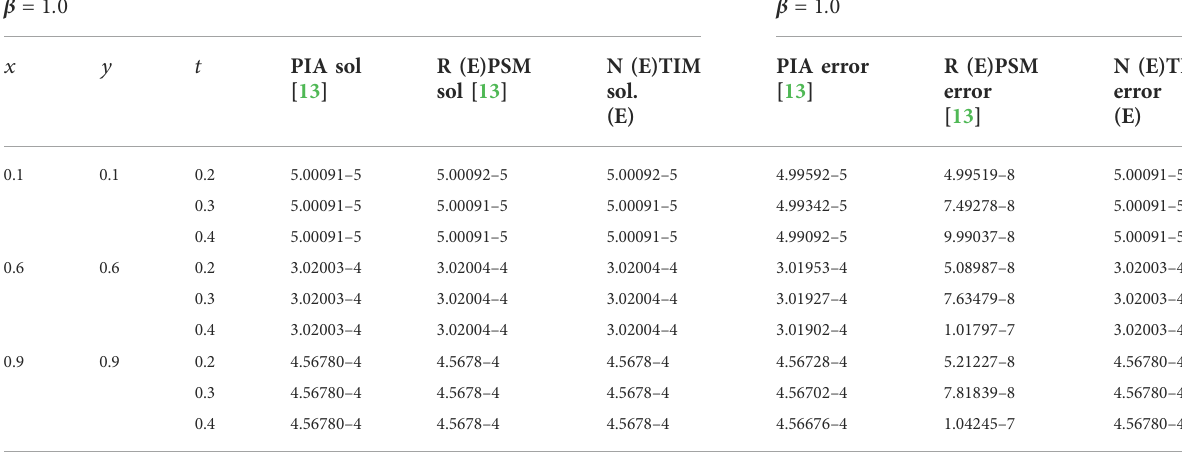
TABLE 5 Comparison of the second-order NTIM with the third-order RPSM and PIA method. β (cid:2) 1 . 0